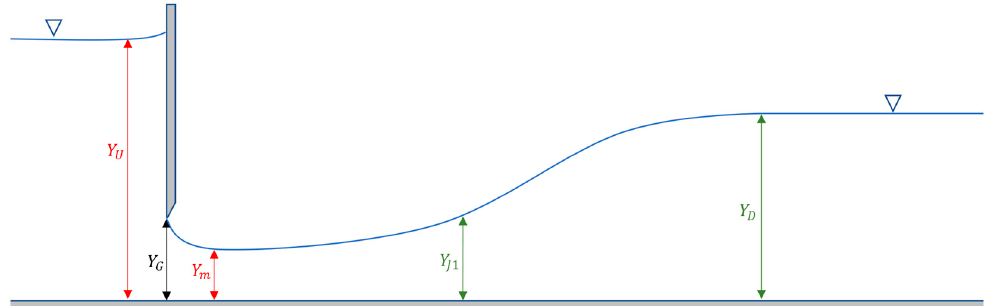
Figure 1. Free hydraulic jump.